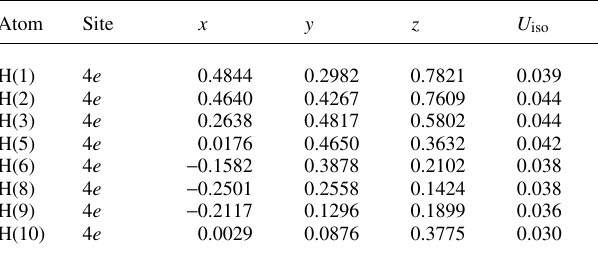
Table 2. Atomic coordinates and displacement parameters (in Å 2 )